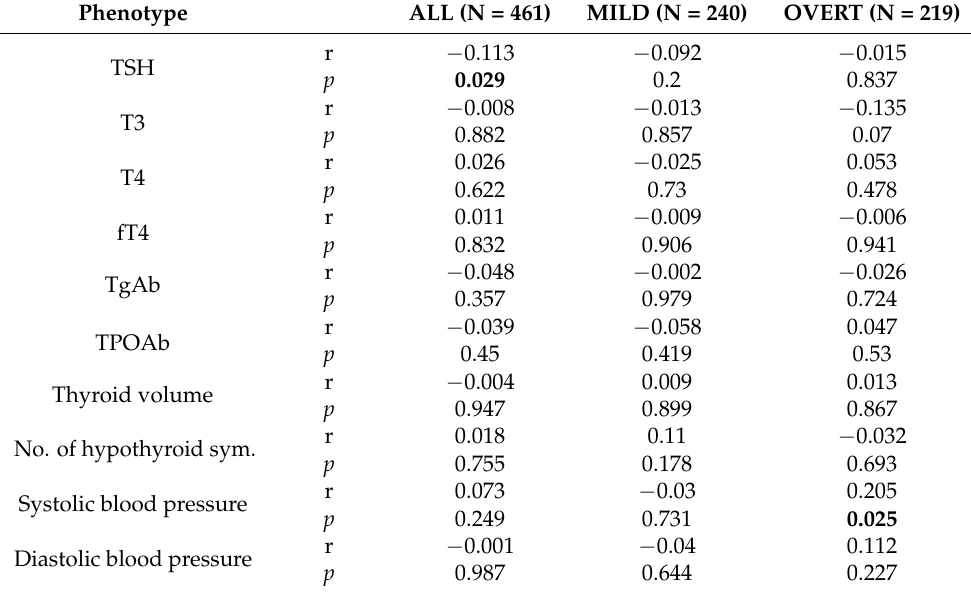
Table 4. Correlation analyses between vitamin D levels and thyroid-related clinical